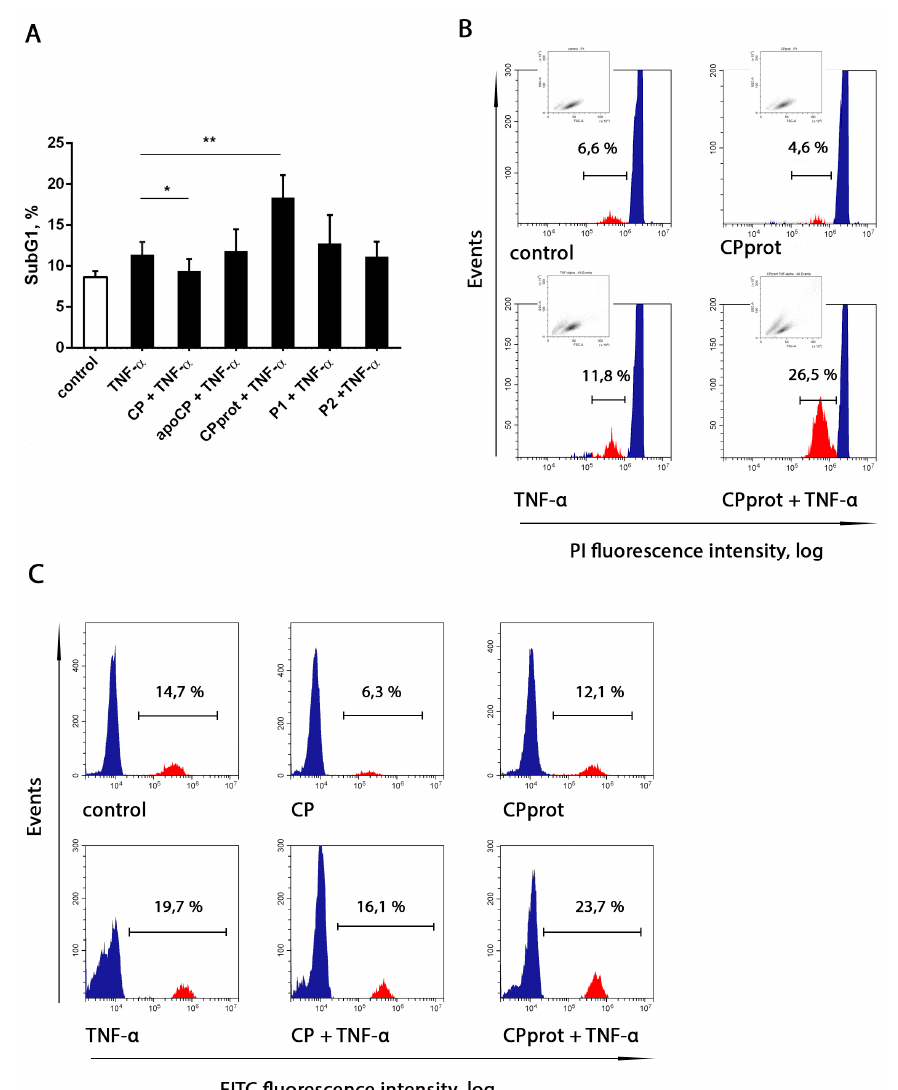
Figure 6. Neutrophil apoptosis with simultaneous exposure to ceruloplasmin (CP) and its derivatives and TNF- α . Polymorphonuclear leukocytes (PMNLs; 10 6 /mL) were cultured at 37 °C with 0.5 µM intact CP, 0.5 µM CPprot (proteolyzed CP), 0.5 µM apo-CP, or 20 µM peptides (P1 or P2), with or without 25 ng/mL TNF- α for 20 h; nuclear DNA fragmentation was assayed both by PI staining of hypo-diploid nuclei and by the detection of DNA strand breaks by TUNEL. ( A ) Presented are pooled data with the percentage of apoptotic cells. Values are the mean ± SEM of duplicate cultures from six independent experiments; * p < 0.05 and ** p < 0.01 (one-way ANOVA followed by Holm–Šídák multiple comparison tests). Representative histograms of apoptotic DNA fragmentation revealed as the SubG1-subpopulation ( B ) and as labeled with FITC-12-dUTP DNA strand breaks ( C ).